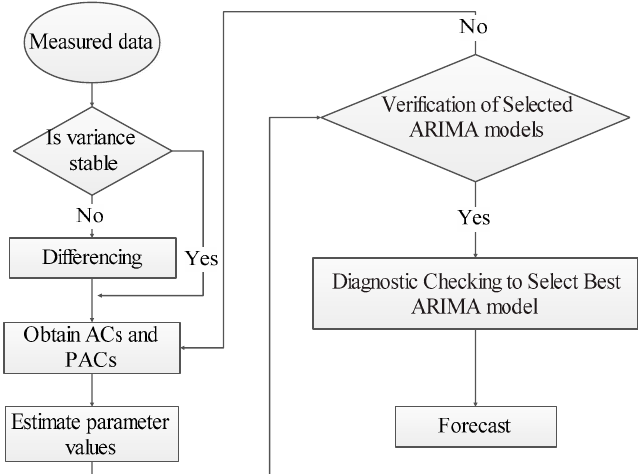
Figure 1. Steps to establish the forecast model, AC is the autocorrelation coefficient and PAC is the partial autocorrelation coefficient